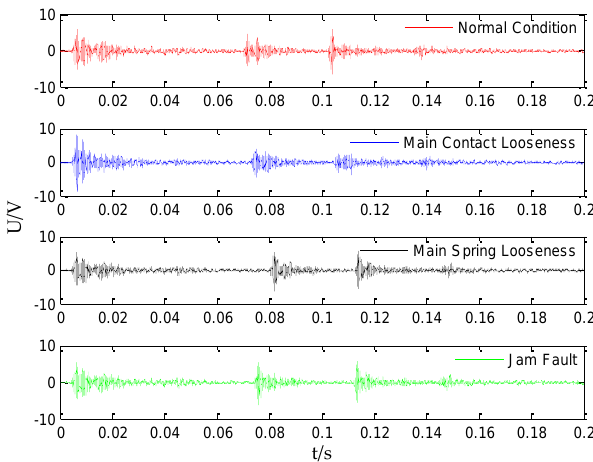
Figure 4. Vibration signals under different conditions.